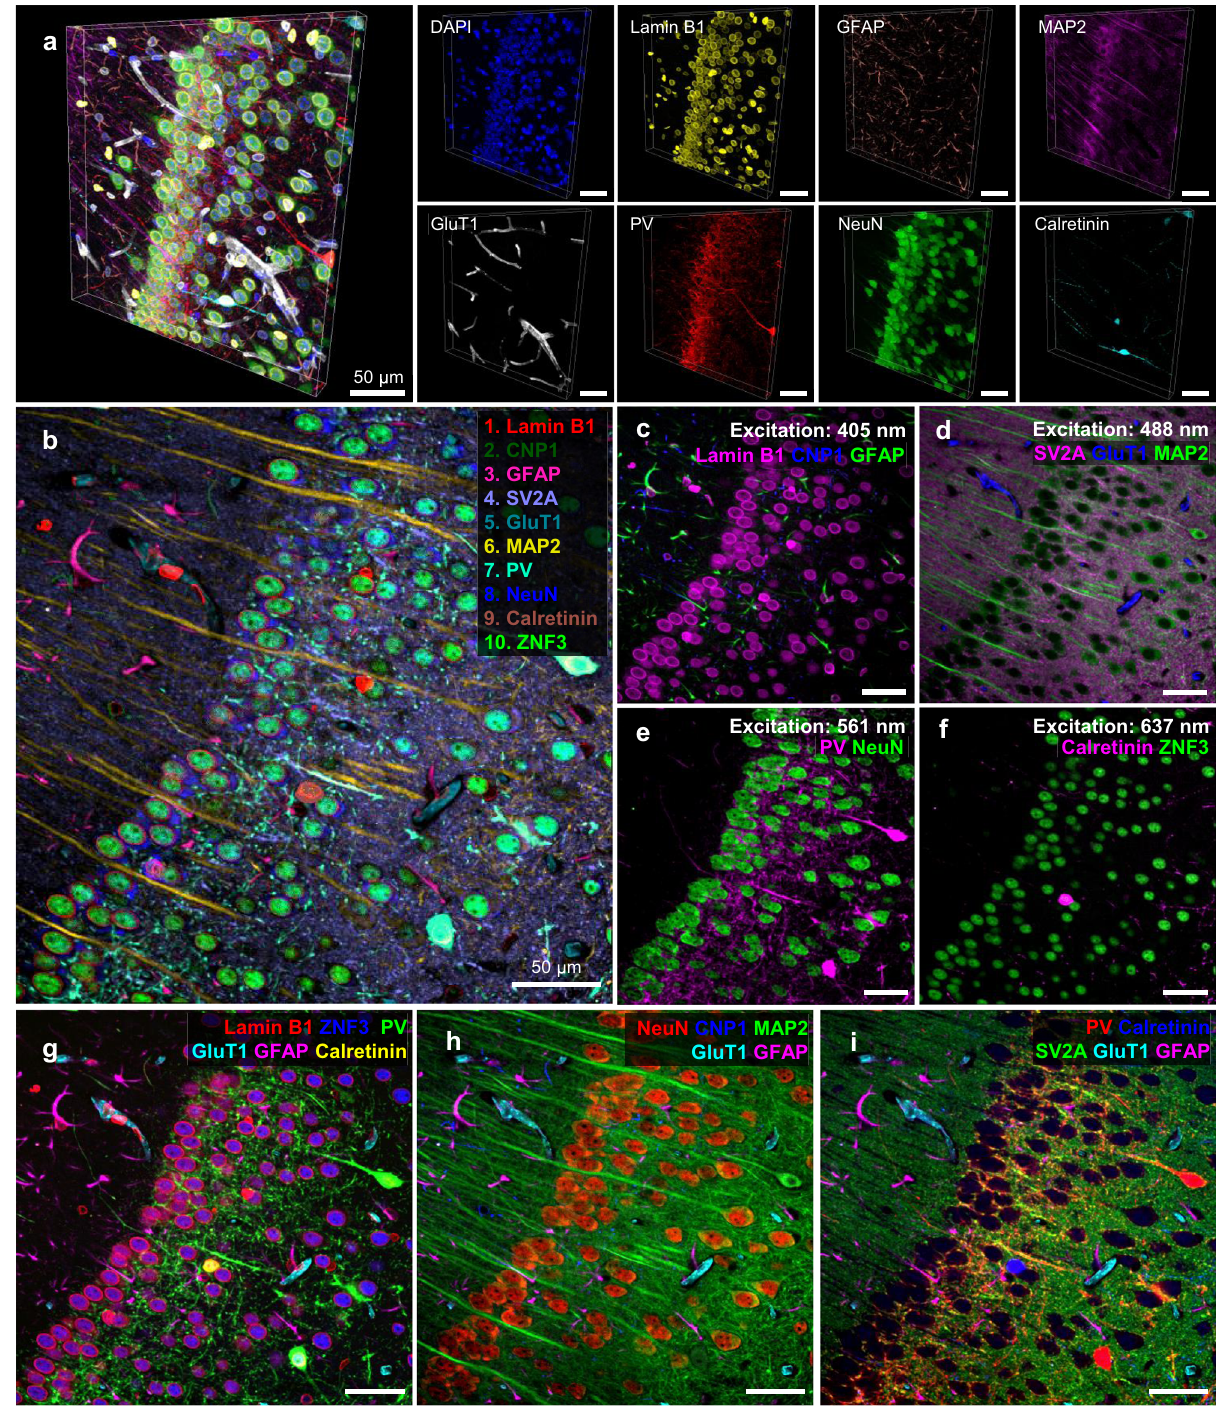
Fig. 6 Three-dimensional multiplexed imaging via PICASSO and the use of PICASSO with microscopy equipped with bandpass fi lters. a Three- dimensional view of a z -stack image acquired from a mouse brain slice that was stained, imaged, and unmixed by PICASSO. Left: Overlay of the eight channels. Right: Single-channel images. b Demonstration of the 10-color multiplexed imaging of the mouse hippocampus CA1 via PICASSO with a microscope equipped with bandpass fi lters. The images were acquired using a confocal microscope equipped with eight bandpass fi lters and four excitation lasers. c – f Two or three channels of the image shown in b acquired by one of the four excitation lasers. The wavelengths of the excitation lasers were c 405 nm, d 488 nm, e 561 nm, and f 637 nm. g – i Overlay of fi ve or six channels chosen from the image shown in b to clearly visualize different sets of biologically relevant channels together. Different display colors were used for proteins in each image to maximize visibility. a – i All primary antibodies were rabbit antibodies. All scale bars; 50 μ